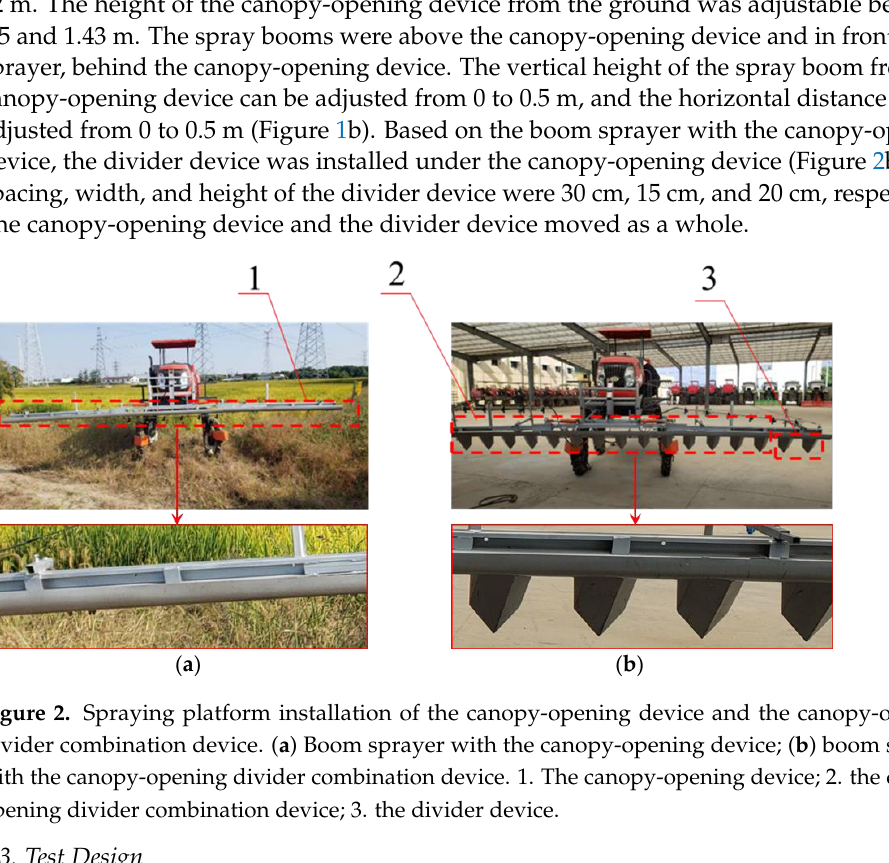
Figure 1. The modified sprayer and the optimization of the canopy-opening device. ( a ) Lifting sys-